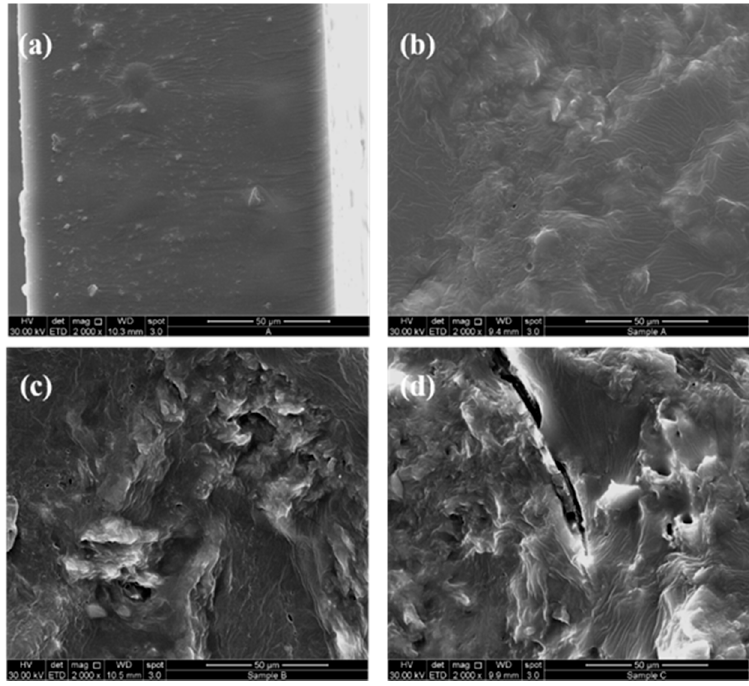
Figure 7. SEM micrographs of pectin film ( a ) and PEC-15 ( b ), PEC-25 ( c ), and PEC-35 ( d ) biocom- posites.